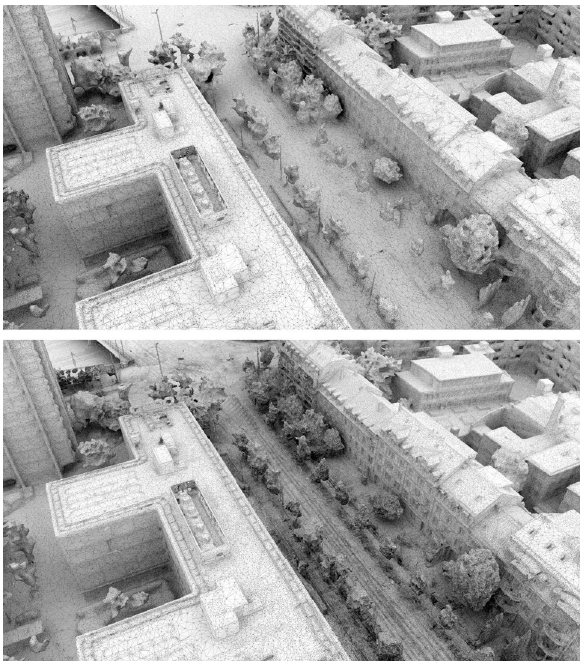
Figure 13. Edged faces renderings of different 3D models of identical sub-scenes. Top: reconstruction using only UAV imagery, bottom: reconstruction using UAV and MMS imagery. The darker is the zone the more details it has since the edges are black and the mesh faces are white.